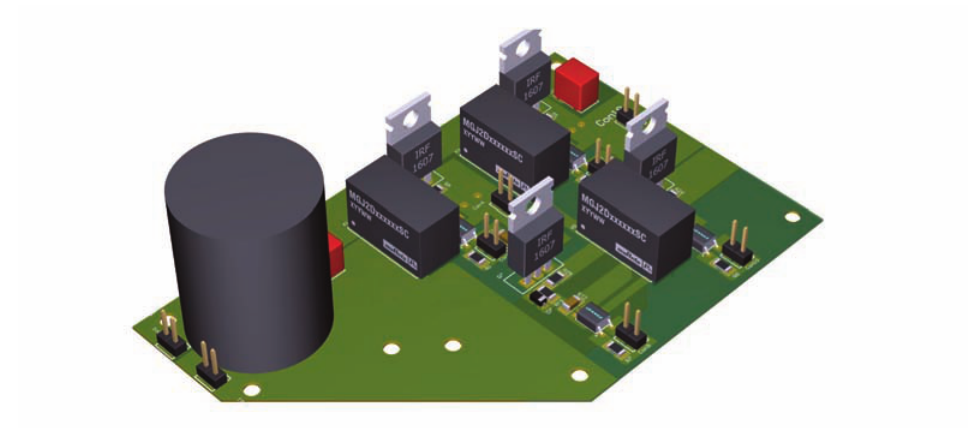
Fig. 13. Circuit diagram of